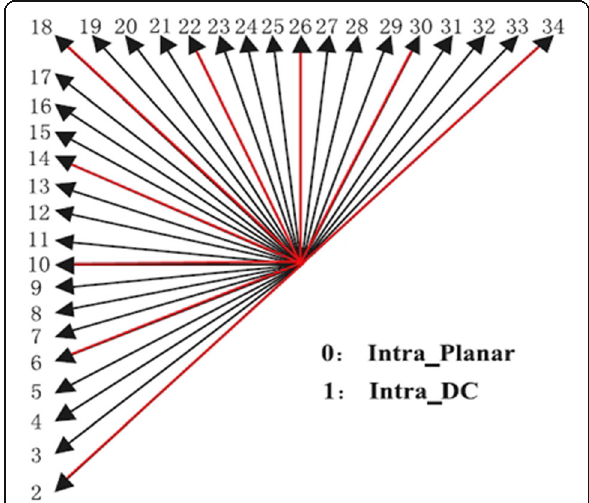
Fig. 6 Selected modes for RMD